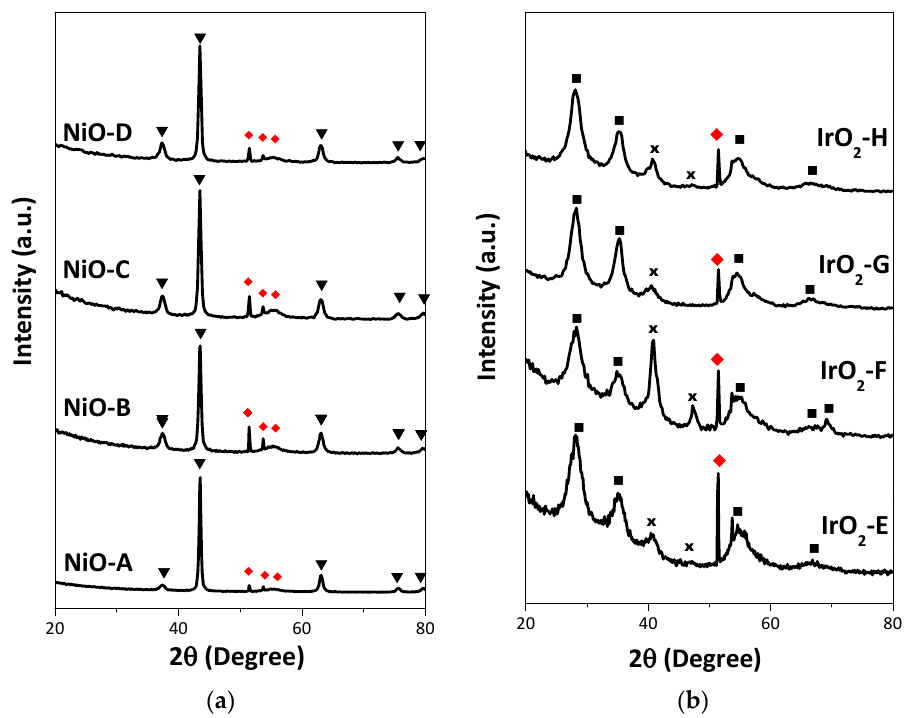
Figure 4. GIXRD patterns of the NiO (Samples A to D) and IrO 2 (Samples E to H) thin films on Si (100) substrate ( (cid:117) ) with the following JCPDS No.: ( a ) (cid:72) cubic NiO (01-073-1519); and ( b ) (cid:4) tetragonal IrO 2 (01-088-0288) and (cid:54) cubic Ir (03-065-1686).